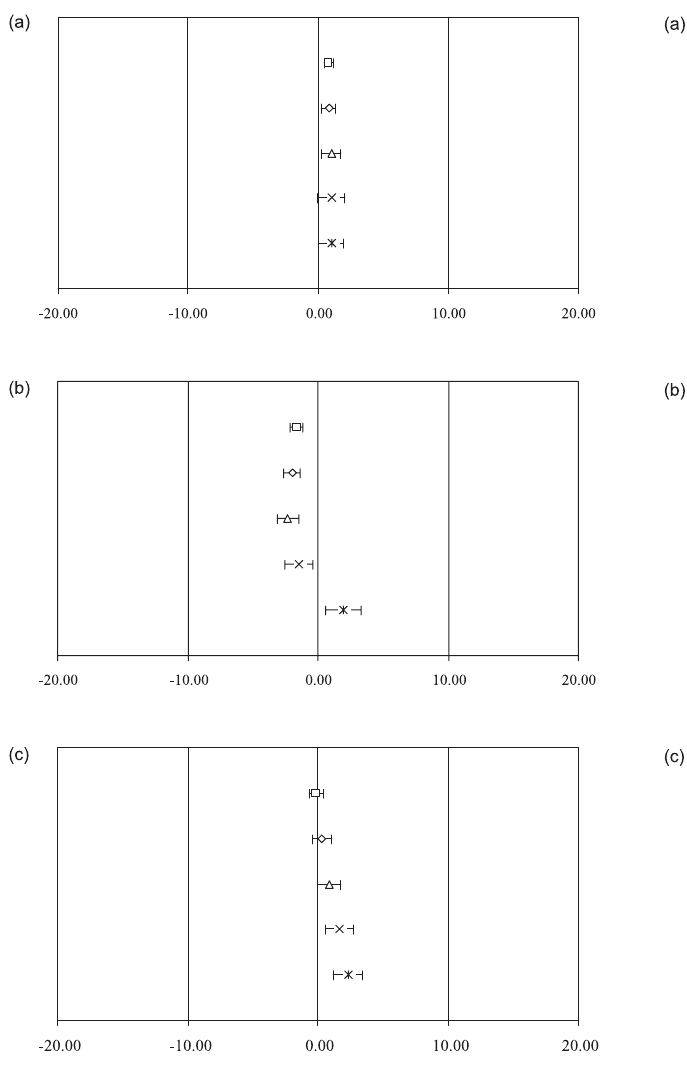
FIGURE 2- Equivalence test (two one-sided test) for dissolution profiles of 10 mg generic versus reference 10 mg (a), 20 mg generic versus reference 20 mg (b) and 40 mg generic versus reference 40 mg (c). Dissolution time-point of 1 (  ), 2 (  ), 4 (  ), 8 (  ) and 12 hours (  ). TABLE II - Results of similarity factor (f2) and two one-sided test (TOST) for dissolution profile comparison of oxycodone extended- release